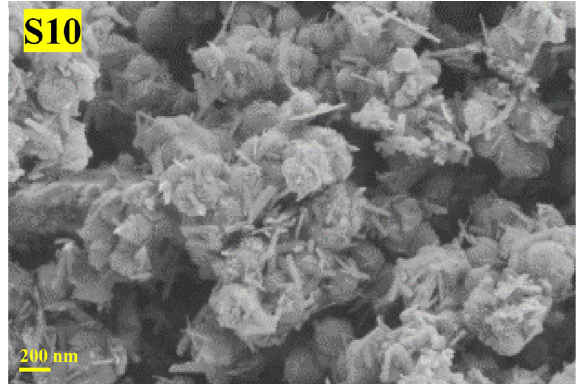
Figure 7. FESEM image of nanourchin-like sample S10.